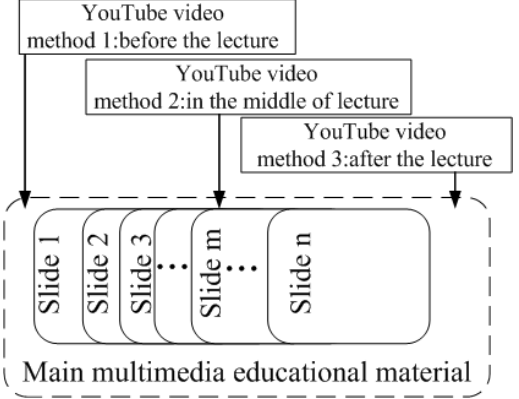
Figure 2. Principle of inserting the supplementary video in lecture